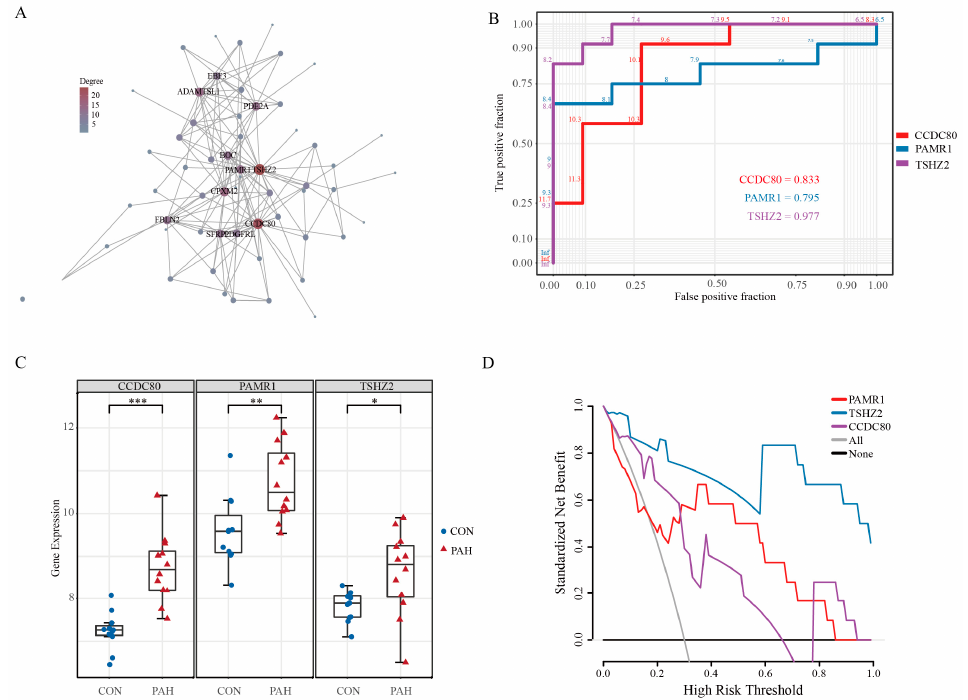
Figure 3. Hub gene selection of white module. ( A ) Network of the white module. ( B ) ROC curve of CCDC80 , PAMR1 , and TSHZ2 . ( C ) The gene expression of CCDC80 , PAMR1 , and TSHZ2 in the validation dataset (GSE53408). ( D ) Decision curve analysis for the PAMR1 , TSHZ2 , and CCDC80 risk prediction models. p -value was calculated using Student’s t -test analysis. * p < 0.05, ** p < 0.01, *** p < 0.001 vs. CON group (student’s t -test). CCDC80 : coiled-coil domain containing 80, PAMR1 : peptidase domain containing associated with muscle regeneration 1, TSHZ2 : teashirt zinc finger homeobox